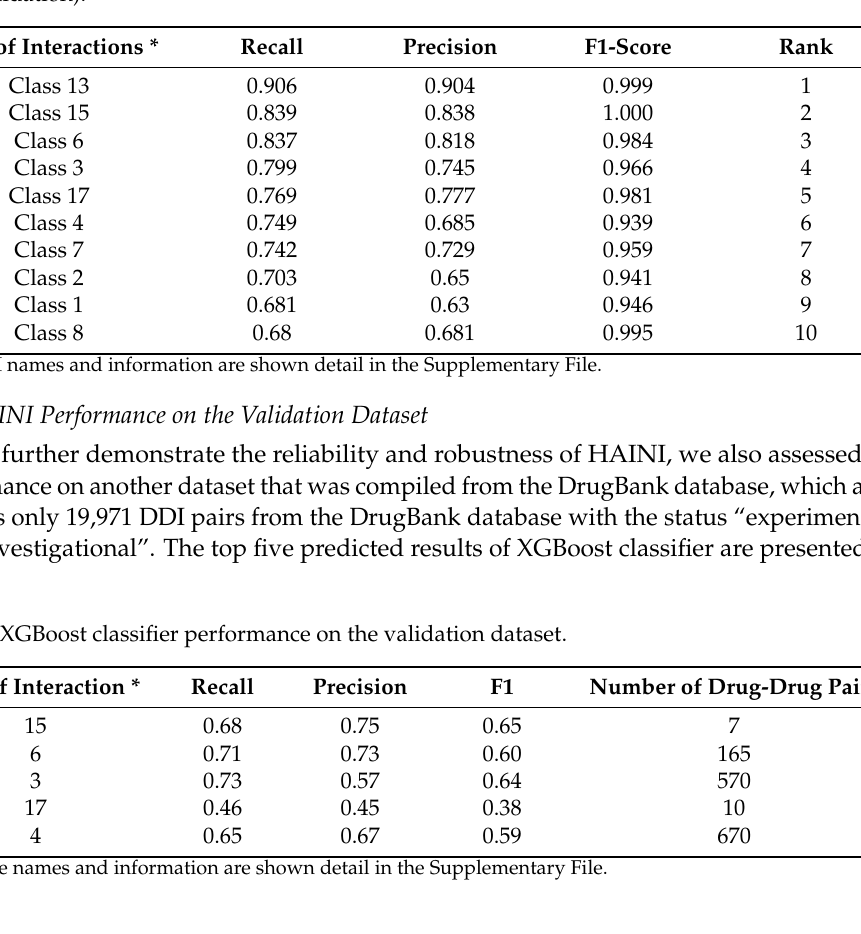
Figure 4. Receiver Operating Characteristic (ROC) curves of five machine learning classifiers. Table 3. Top 10 DDI types having highest precision when classifying with XGBoost algorithm (5-fold cross-validation).